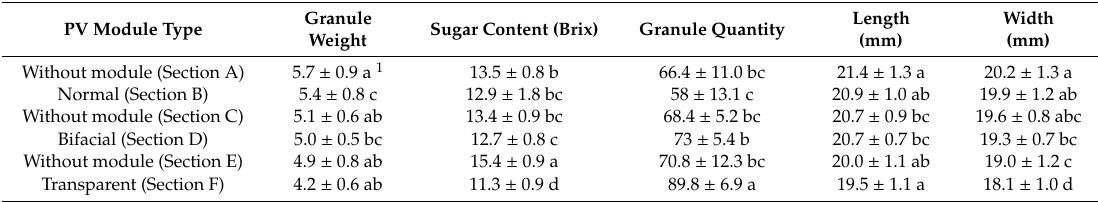
Table 2. Grape-growth results by photovoltaic (PV) module type.